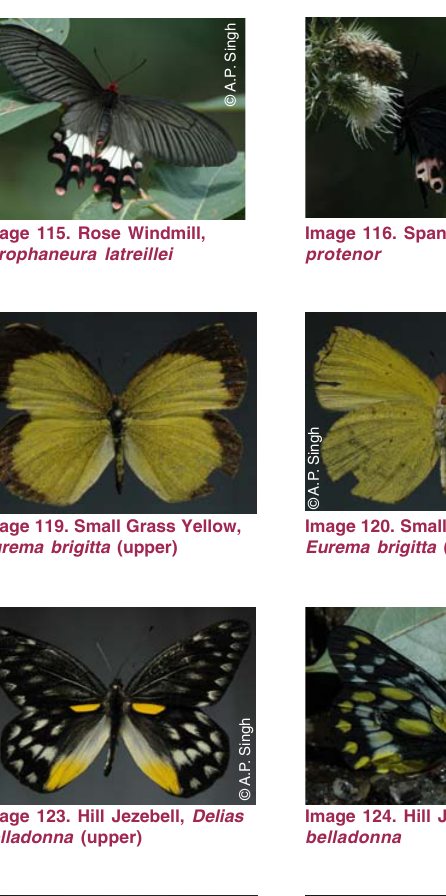
Image 126. Large Cabbage White, Pieris brassicae